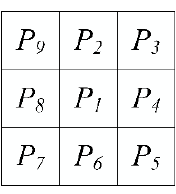
Figure 6. Obstacle description in binary image.